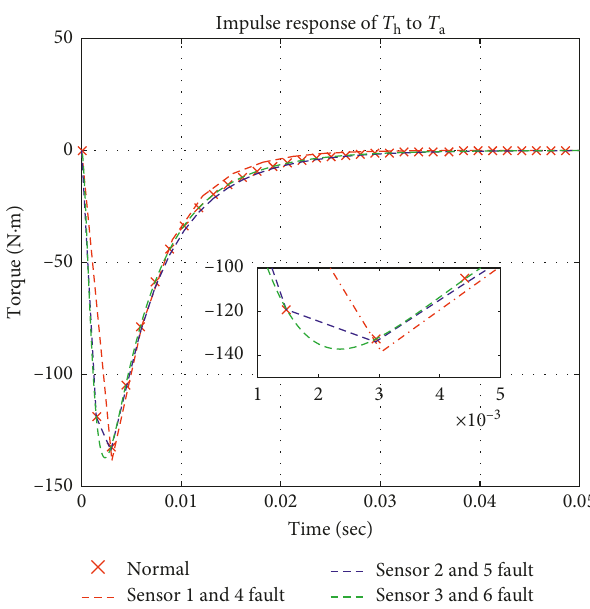
Figure 7: The impulse response of EPS system with two sensor failure.